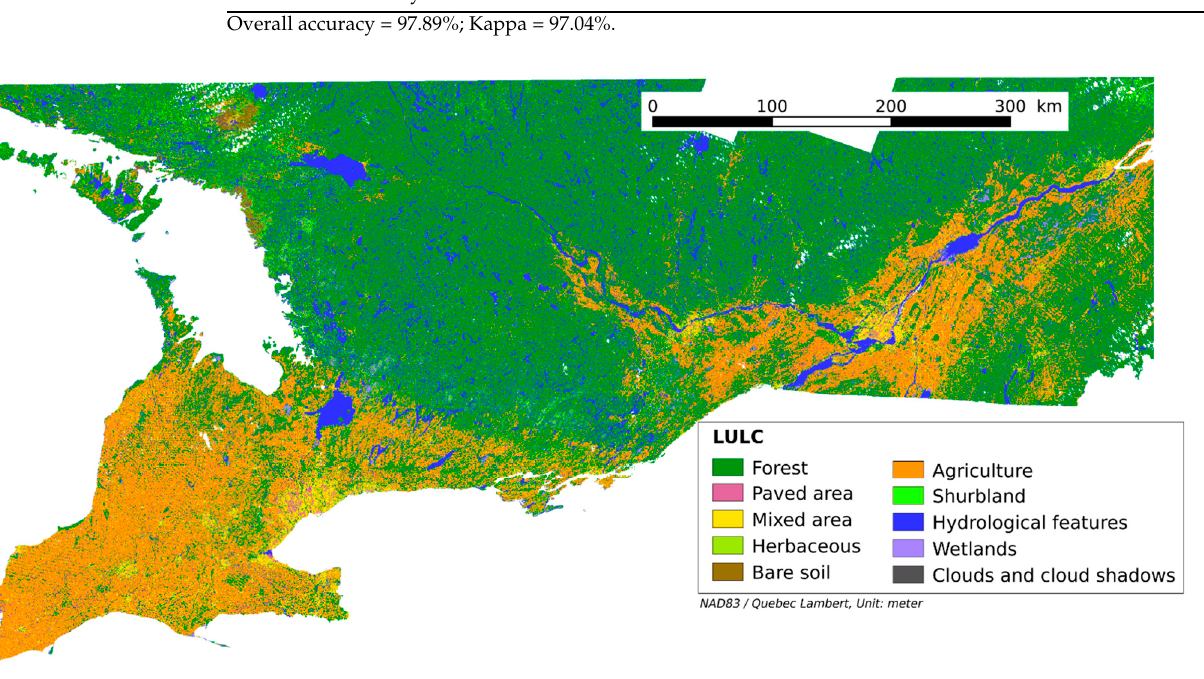
Table A2. Environmental data. Derived layers with an asterisk were not used to build the models.